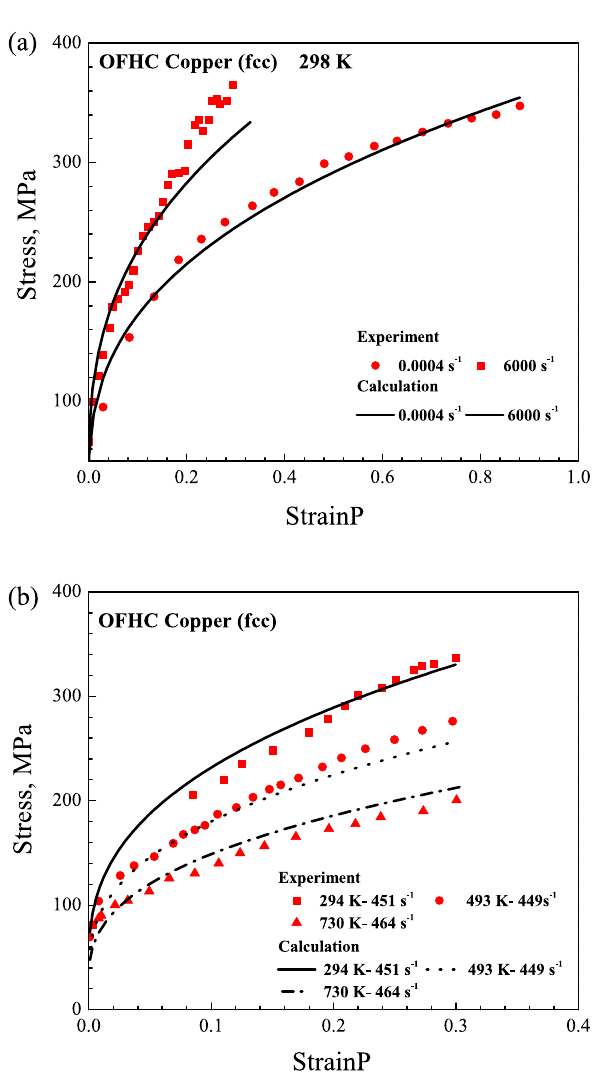
Figure 2. Comparison of stress–plastic strain curves for OFHC Cu between the calculated and experimental results at different temperatures and strain